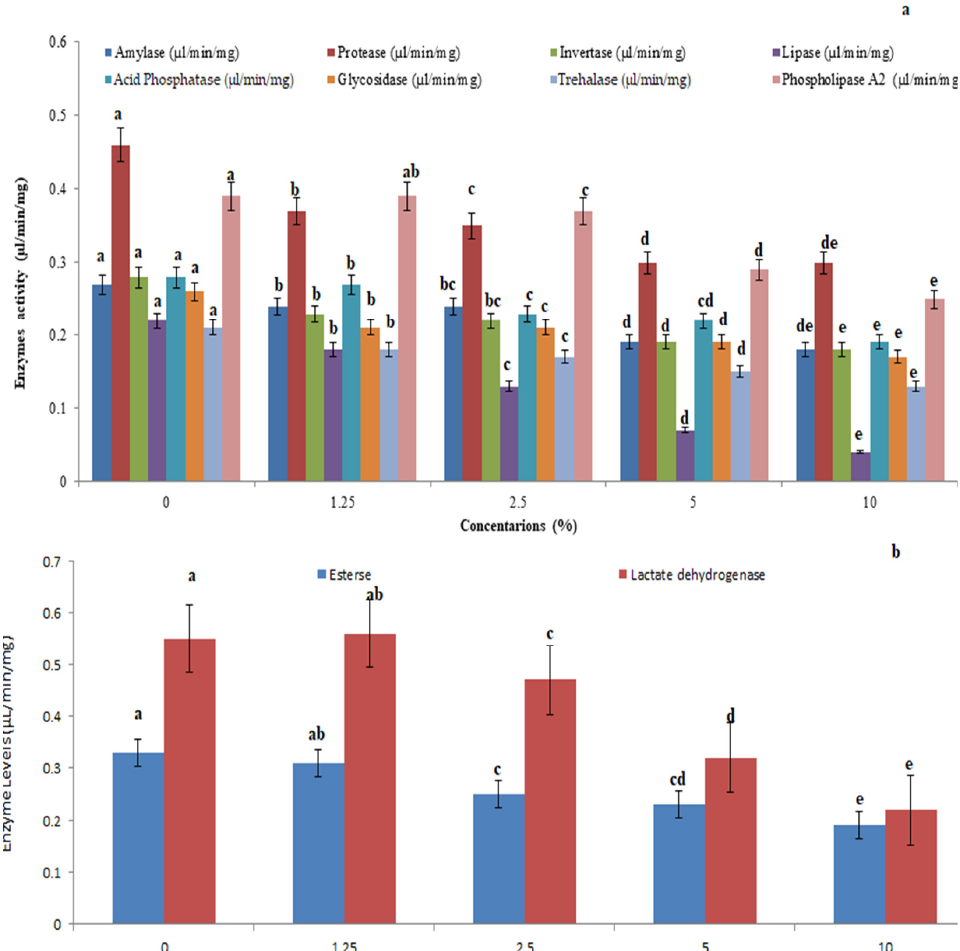
Figure 3. Whole insect body hydrolytic enzyme levels of amylase, protease, invertase, lipase, acid phosphatase, glycosidase, trehalase, and phospholipase A 2 ( a ) and levels of detoxification enzymes esterase and lactate dehydrogenase ( b ) in insect P. solenopsis exposed to vijayneem at different concentrations. Different letters (among the same concentration for each enzyme separately) above bars indicate significantly different means according to Tukey’s test ( p < 0.05). Bars indicate the standard error